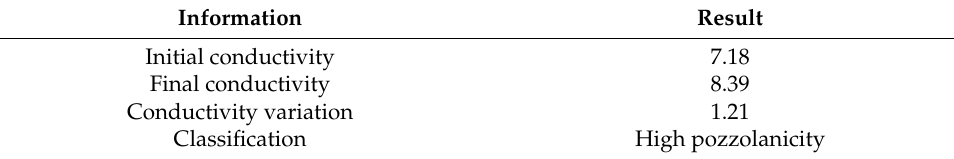
Table 4. Pozzolanic activity by Lux á n